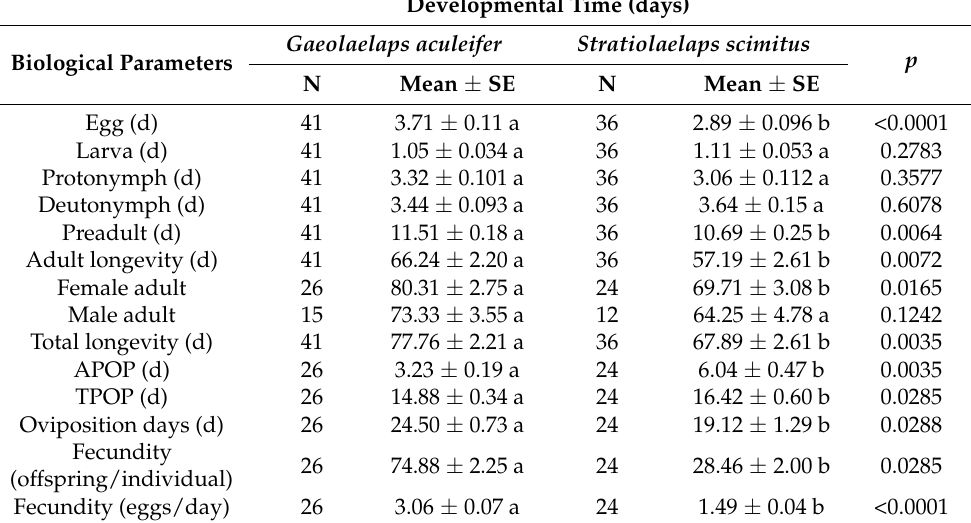
Table 1. Development time for the different life stages, total preadult duration, adult longevity, adult preoviposition period (APOP), total preoviposition period (TPOP), reproductive days, and fecundity of G. aculeifer and S. scimitus fed on T. putrescentiae . Developmental Time